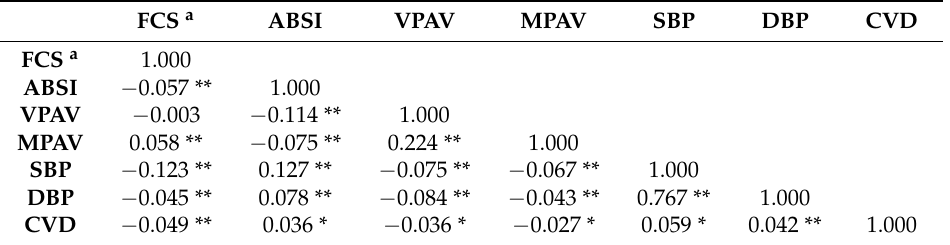
Table 2. Correlation matrix of proposed variables on cardiovascular